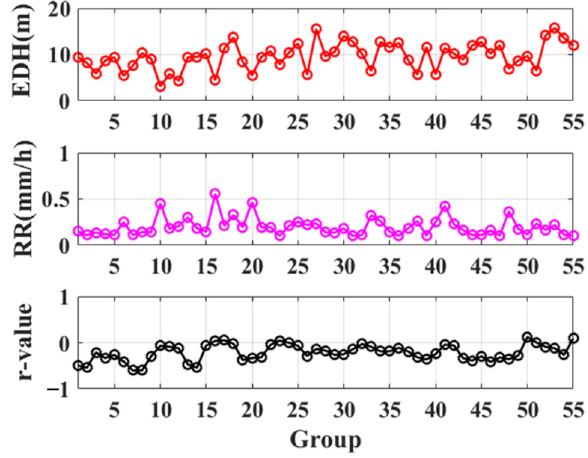
Figure 18. The Pearson correlation coefficients of the EDH and RR in the study area.